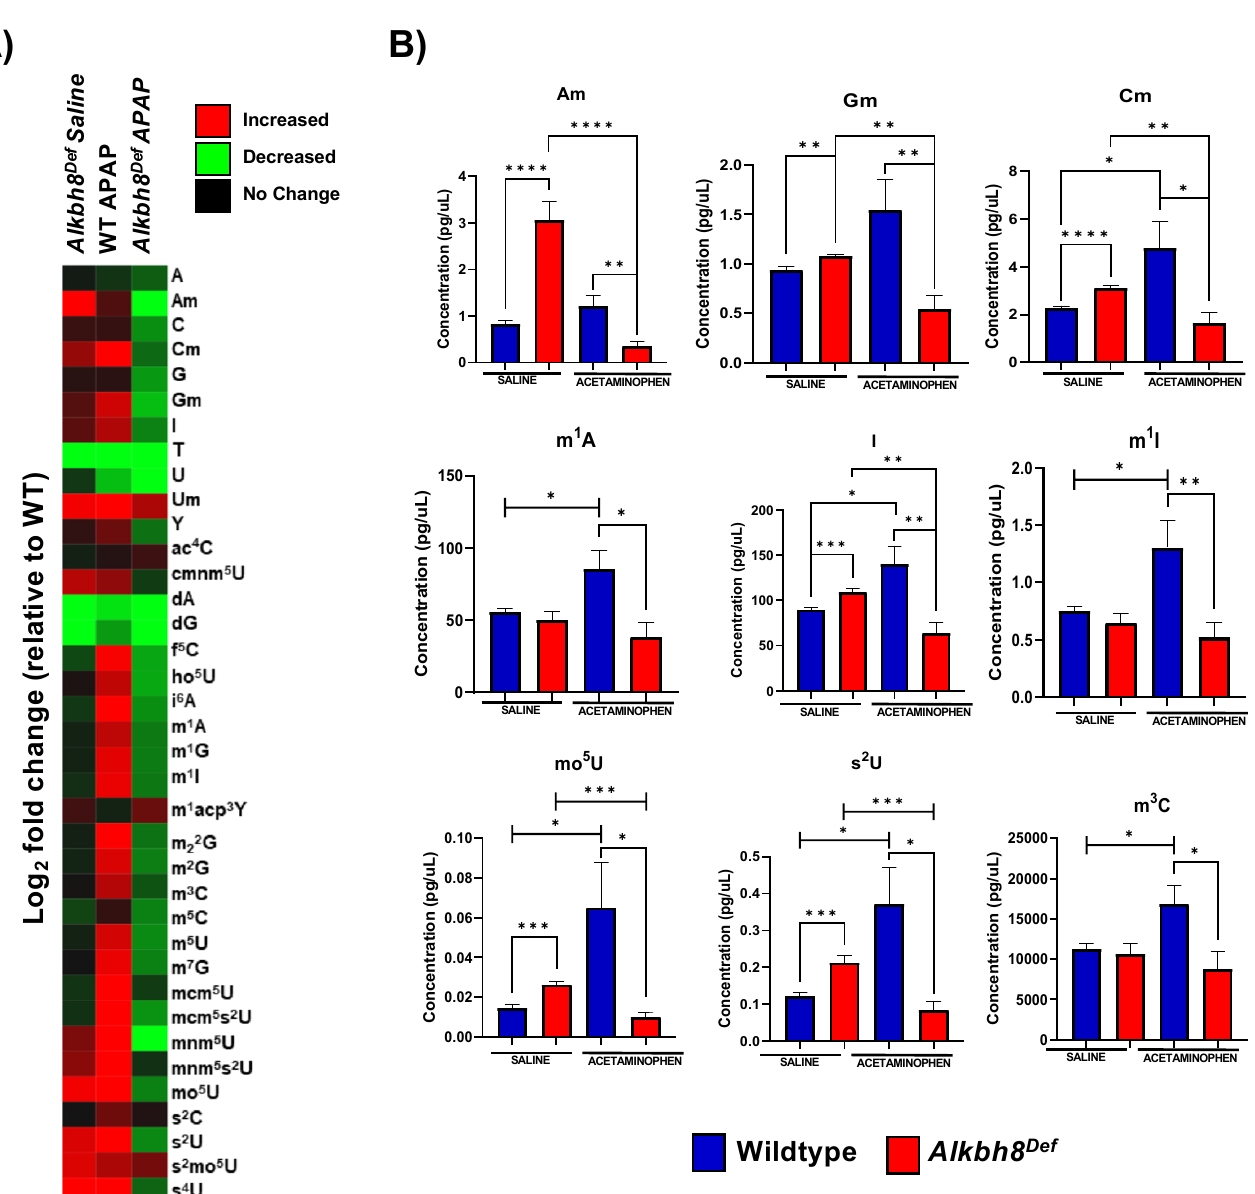
Figure 5. The epitranscriptome is differentially regulated in WT and Alkbh8 Def livers in response to a single dose of APAP. ( A ) 37 epitranscriptome marks were measured with LC-MS/MS and the log 2 - fold change was normalized relative to WT saline data and shown as a heat map. ( B ) Data for each modification under the four conditions was compared for statistical significance (N = 3) using an unpaired t -test with (* p < 0.05, ** p < 0.01, *** p < 0.001 and **** p < 0.0001). Results of LC-MS/MS analysis confirmed the disrupted response of many tRNA modifcaitons under chronic APAP condtions. In response to APAP the WT liver tissue showed significant increases in six modifications, and decreases in two modifications relative to WT saline. The Alkbh8 Def mice had nine modifications significantly decreased after APAP exposure and five increased, relative to Alkbh8 Def saline. The modification that had a similar response to acute conditions was m 1 A, with WT liver showing increases after APAP exposure and Alkbh8 Def liver showing decreases. Many uridine modifications were measured to be significantly dysregulated in the Alkbh8 Def liver tissue compared to WT after daily APAP exposure including: m 5 U, mcm 5 s 2 U, mnm 5 U, mnm 5 s 2 U, and s 2 U. It is interesting to note that s 2 U was measured to be increased after daily APAP